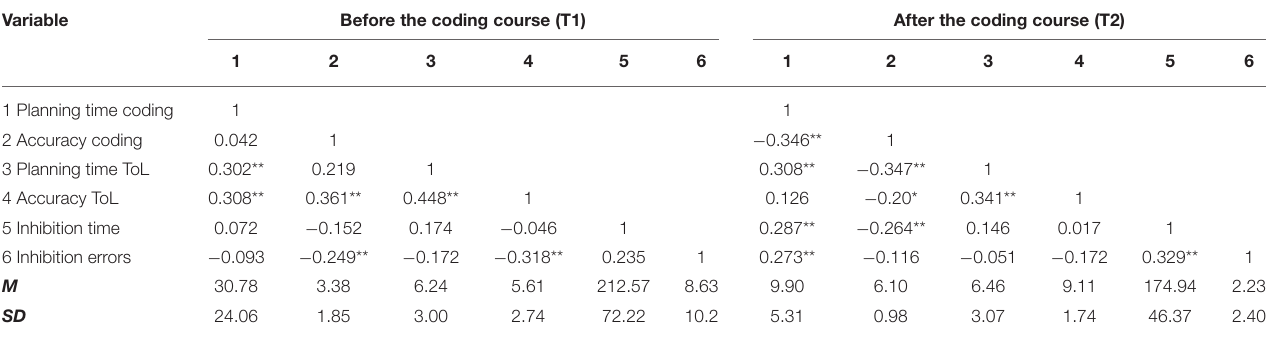
TABLE 4 | Means, standard deviations and intercorrelations between measures before and after the coding course.